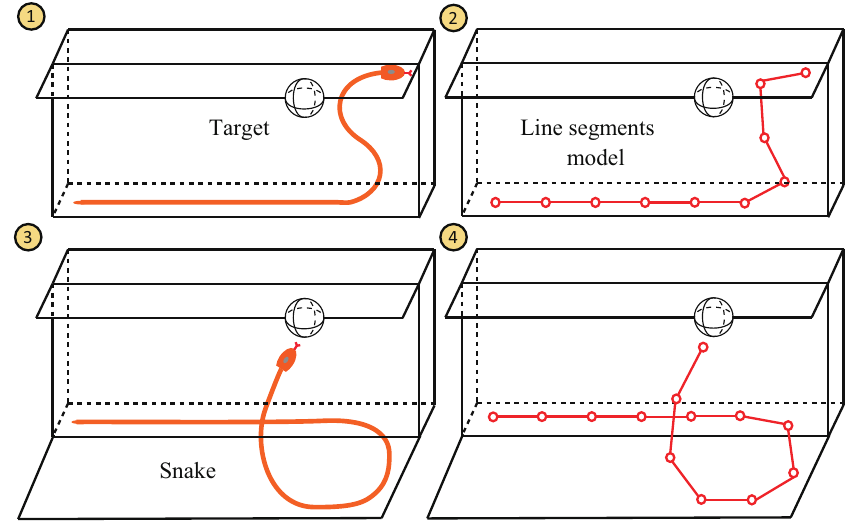
Figure 1. The concepts of 2D and 3D head-raising. Label 1 and 2 represent 2D head-raising, and label 3 and 4 show 3D